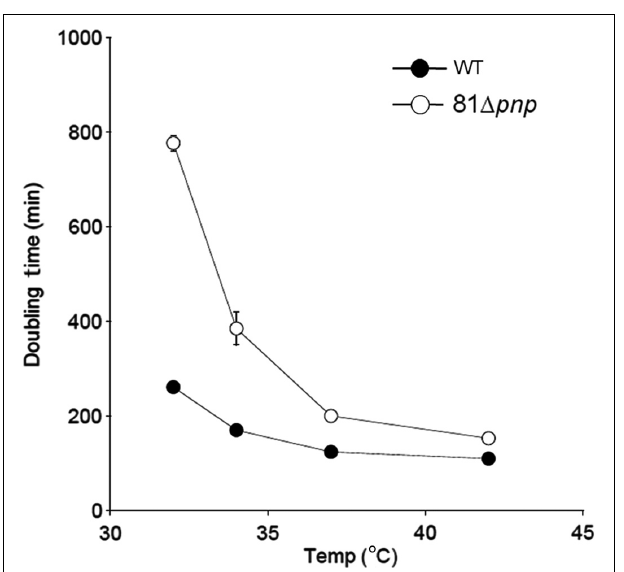
FIGURE 2 | Mean generation time of the parental strain (solid circles) versus the mutant strain (open circles). C. jejuni was cultivated in BHI broth and incubated in microaerobic condition at 32, 34, 37, and 42 ◦ C. Experiments were performed three times